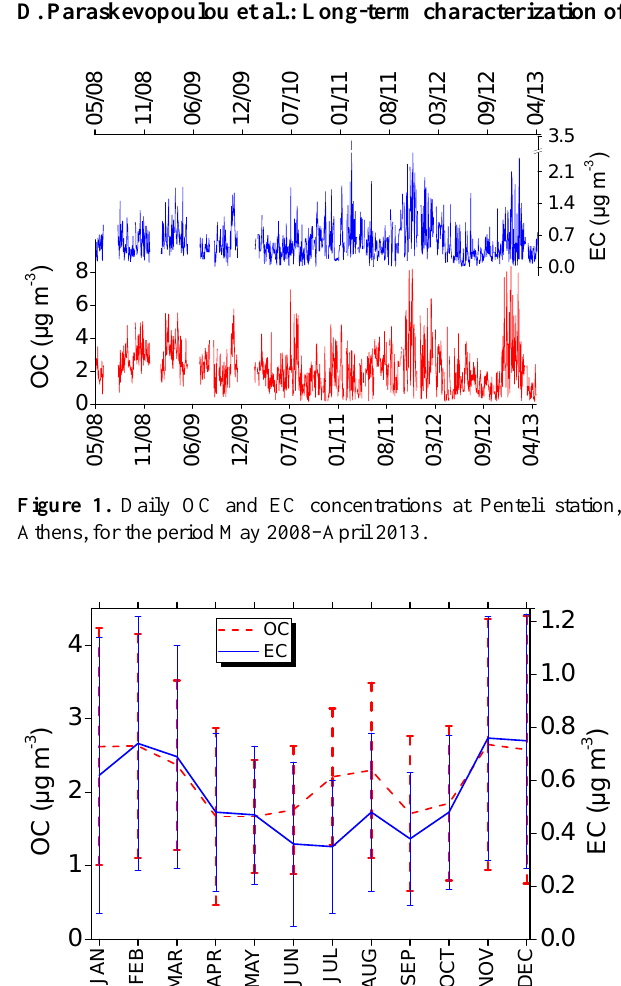
Figure 2. Average seasonal cycle of OC and EC concentrations cal- culated from daily values for the period May 2008–April 2013.